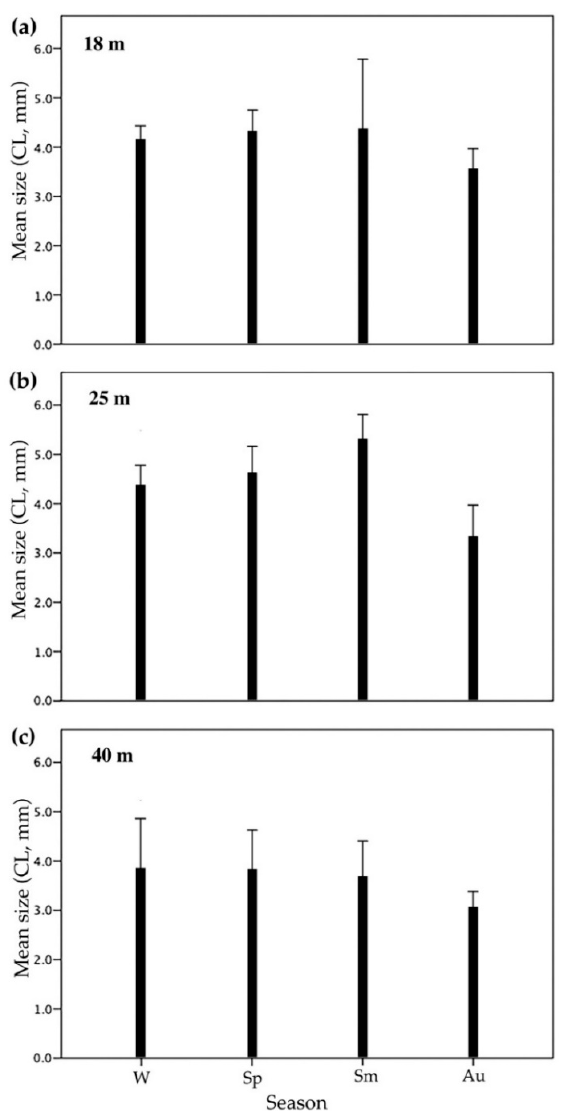
Figure 5. Mean size (carapace length, + SE of means) of N. melanodactylus at each season (W: winter, Sp: spring, Sm: summer, Au: autumn) and at ( a ) 18 m, ( b ) 25 m, and ( c ) 40 m. Carapace length (CL) was measured in mm.